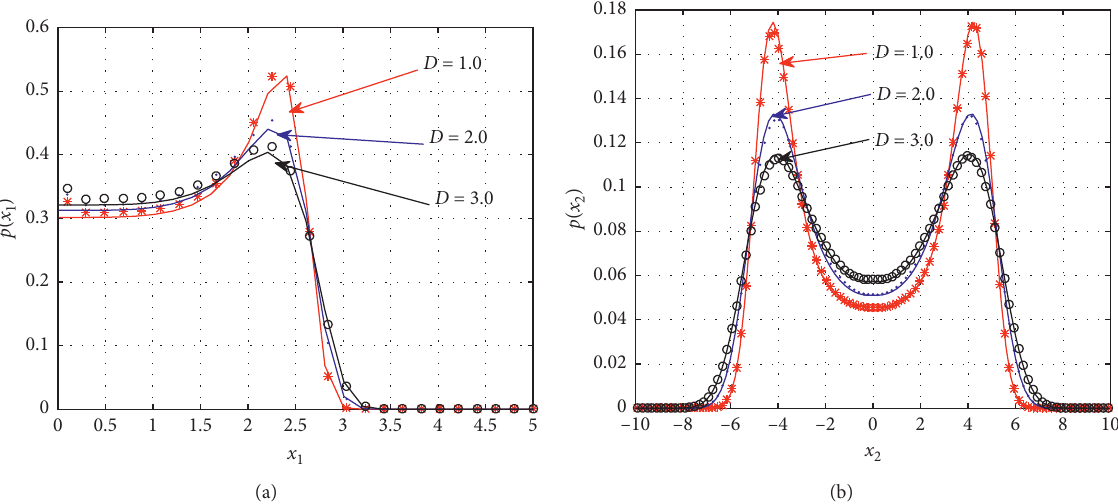
Figure 11: Stationary PDFs as r � 0 . 99: (a) displacement x